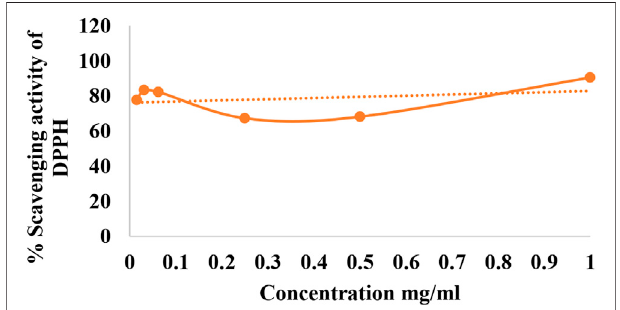
FIGURE 1 | Percentage scavenging activity of DPPH.